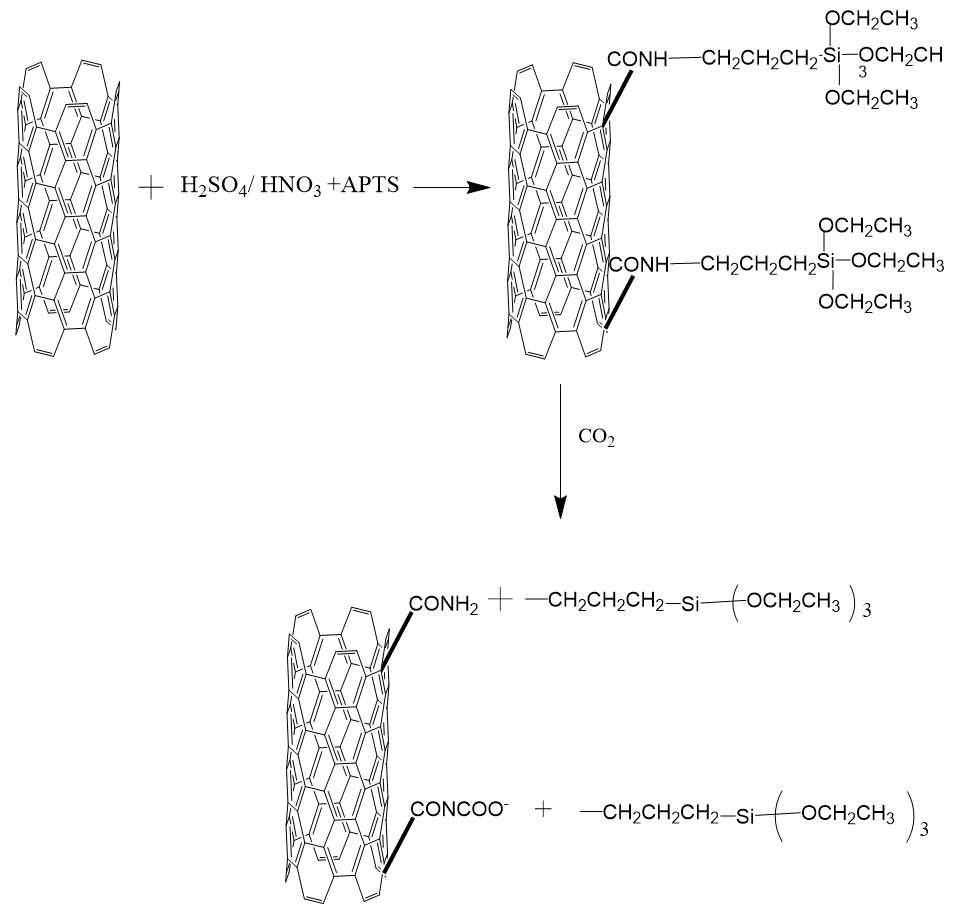
Figure 9. The mechanism for functionalization of acid treated MWCNTs with 3-aminopropyltrieth- oxysilane (APTES) (Reprinted with permission from ref. [109]).